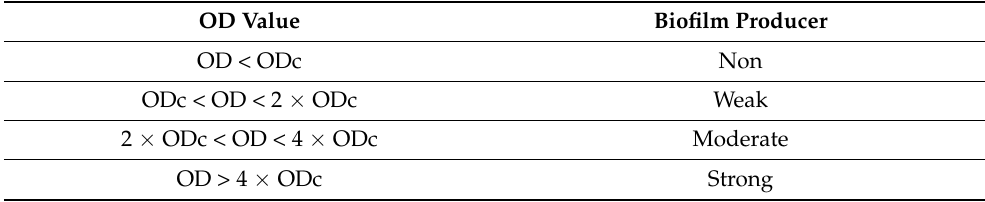
Table 1. The criteria for evaluation of biofilm